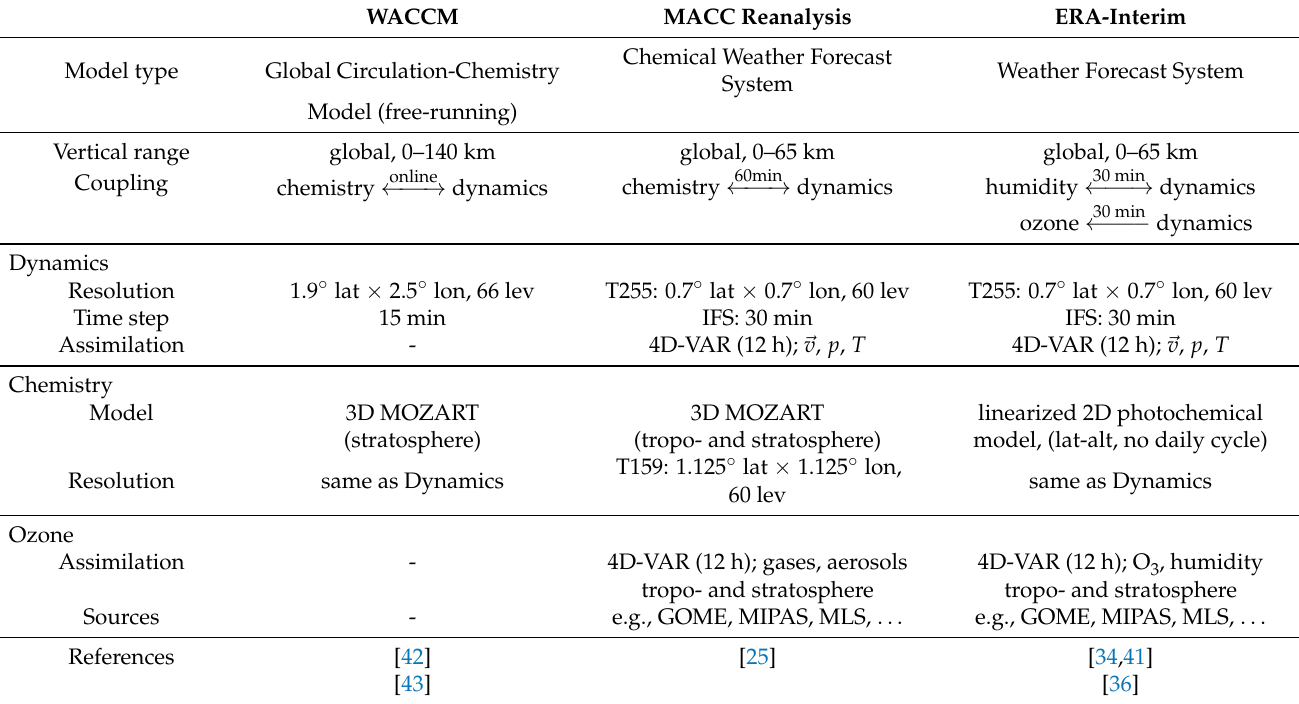
Table 1. Overview on the implementation, data assimilation and resolution of the model systems of WACCM, MACC reanalysis, and ERA-Interim (lat = latitude, lon = longitude, lev = level, IFS = Integrated Forecast System). WACCM MACC Reanalysis ERA-Interim Chemical Weather Forecast Model type Global Circulation-Chemistry